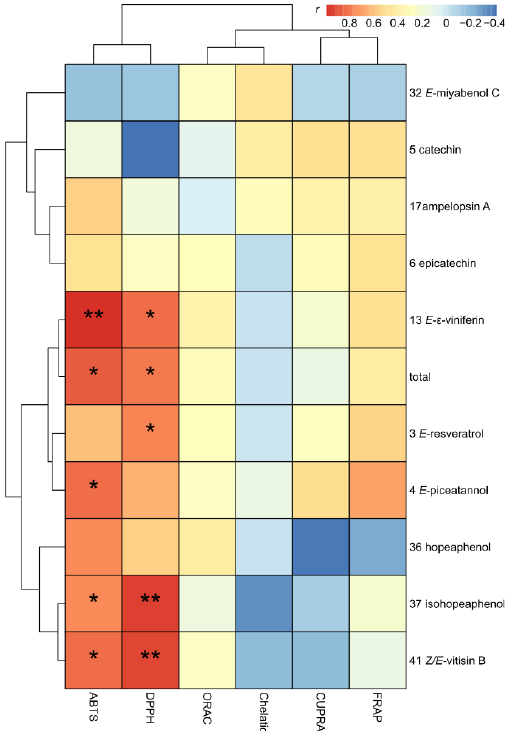
Figure 3. Pairwise Spearman correlations of single-metabolite and antioxidants tests (R; * p < 0.05 and ** p < 0.01). The heatmap clearly discriminated two clusters of polyphenols. The first group, including E -resveratrol (3), E -piceatannol (4), E - ε -viniferin (13), hopeaphenol (36),